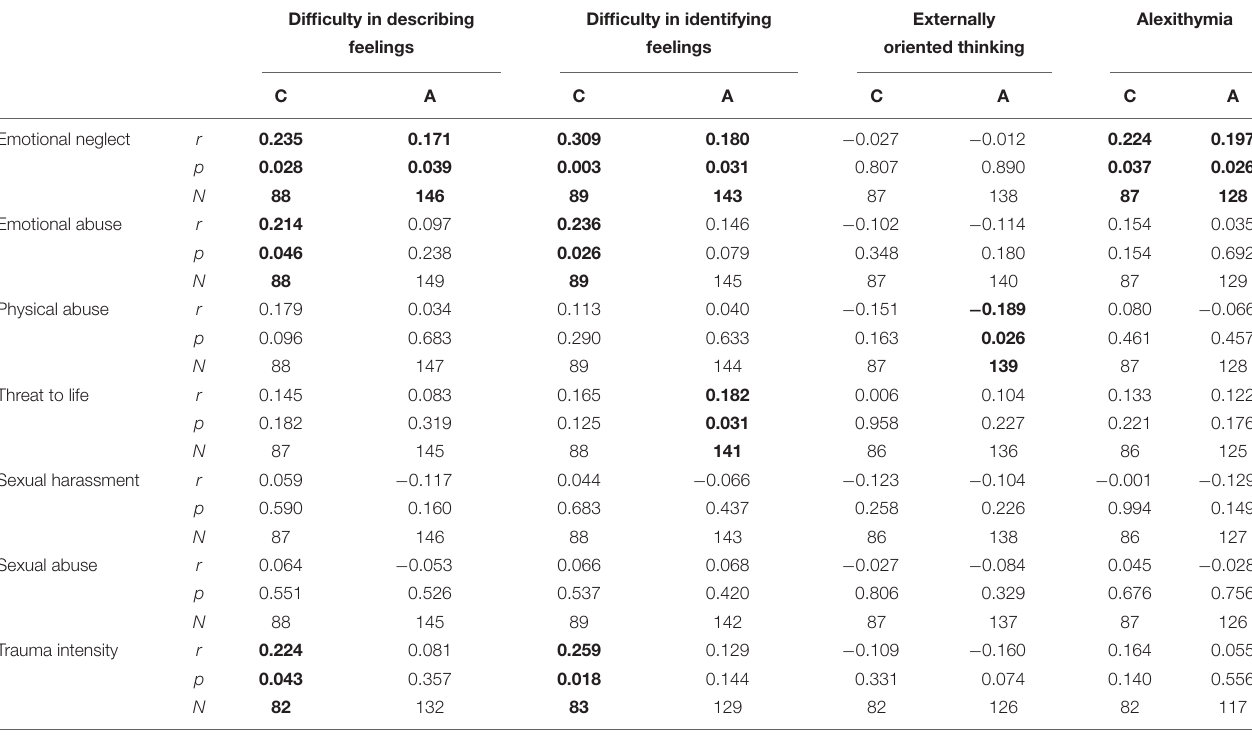
TABLE 3 | Correlation matrix between traumatic experience and alexithymia. Difficulty in describing